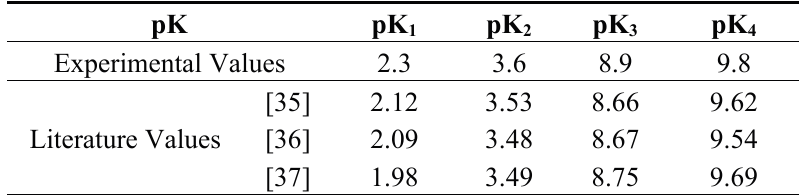
Table 2. Experimentally determined glutathione acid dissociation constants and literature values at 25 °C, ionic strength (I) = 0.1 M KCl.